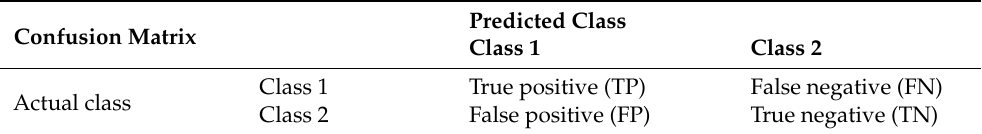
Table 1. The schematic table of the confusion